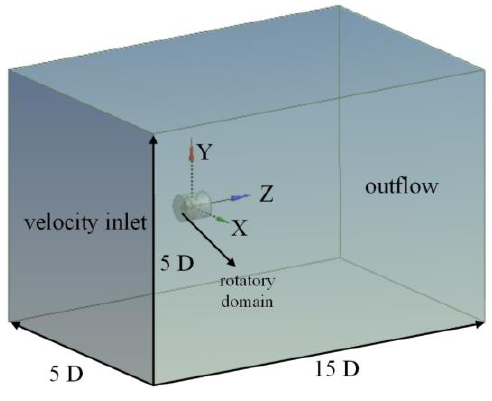
Figure 5. Calculation